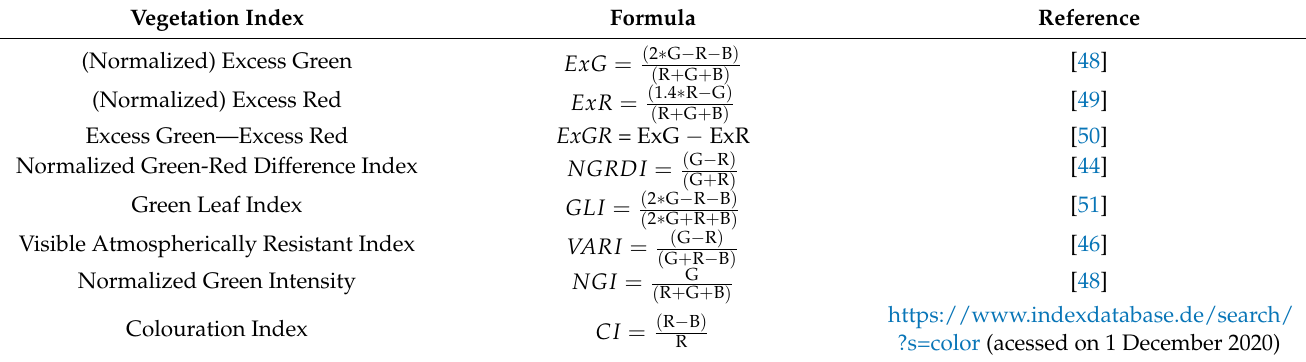
Table 3. List of Vegetation Indices (VIs) derived from the RGB camera